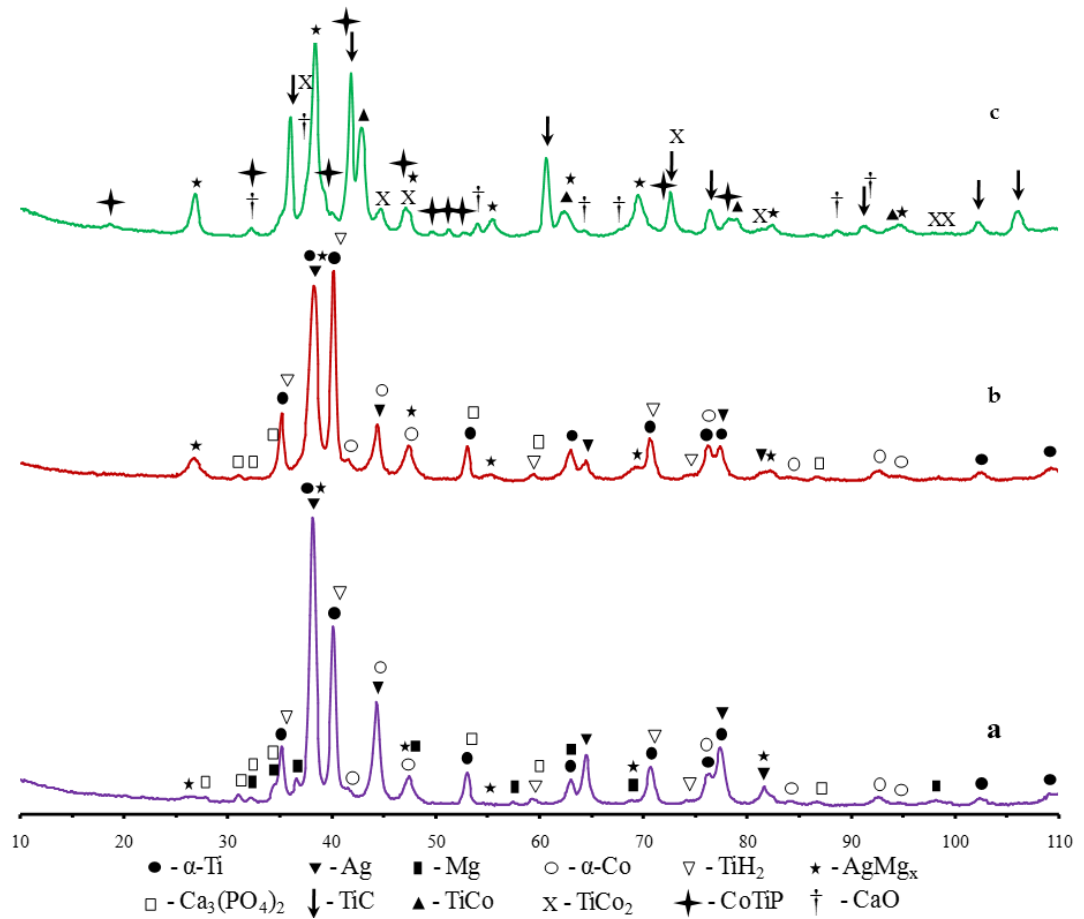
Figure 1. Diffraction patterns of the Ti – C – Co – Ca 3 (PO 4 ) 2 – Ag – Mg powder mixtures at X = 24% after the MA lasting for 3 ( a ), 10 ( b ), and 11 ( c ) min.